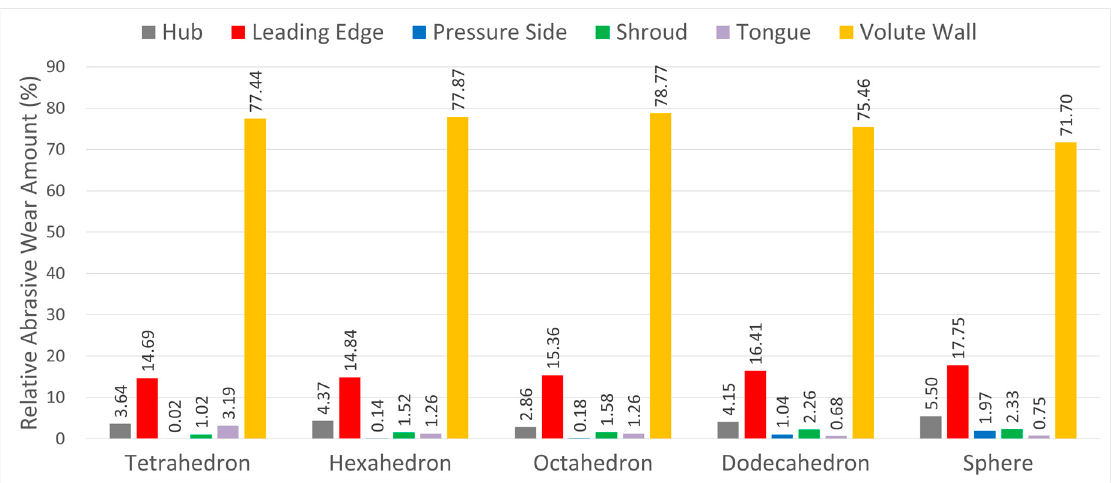
Figure 9. Relative abrasive wear amount of flow parts.